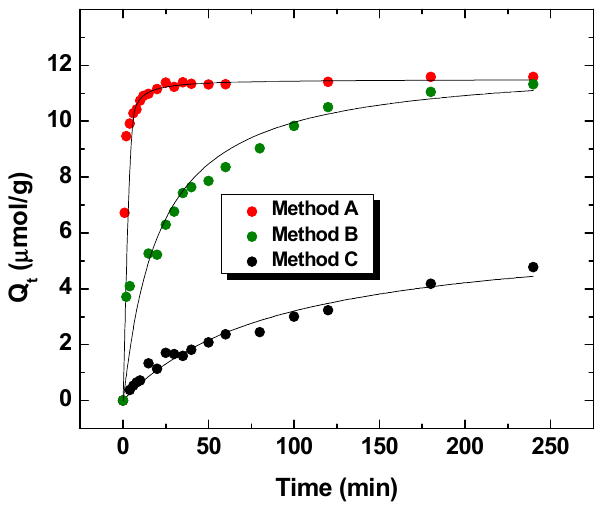
Figure 1. Kinetic profiles for a cross-linked organic copolymer (CDI-2) with p -nitrophenol (PNP) in aqueous solution at pH 4.60 and 298 K using different experimental methods. The solid lines represent the “best-fit” using the pseudo-second order (PSO) kinetic